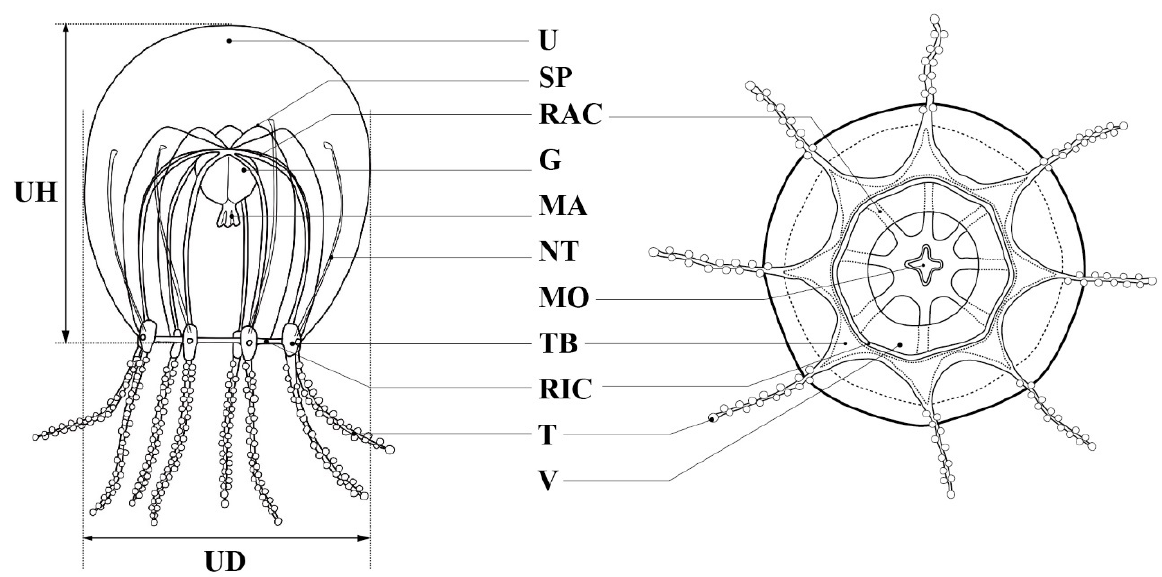
Figure 2. Key characters for identification and measurement of parts of the Halimedusidae: G = gonad; MA = manubrium; MO = mouth; NT = nematocyst track; RAC = radial canal; RIC = ring canal; SP = subumbrellar peak; T = tentacle; TB = tentacle bulb; U = umbrella; UD = umbrella diameter; UH = umbrella height; V = velum.